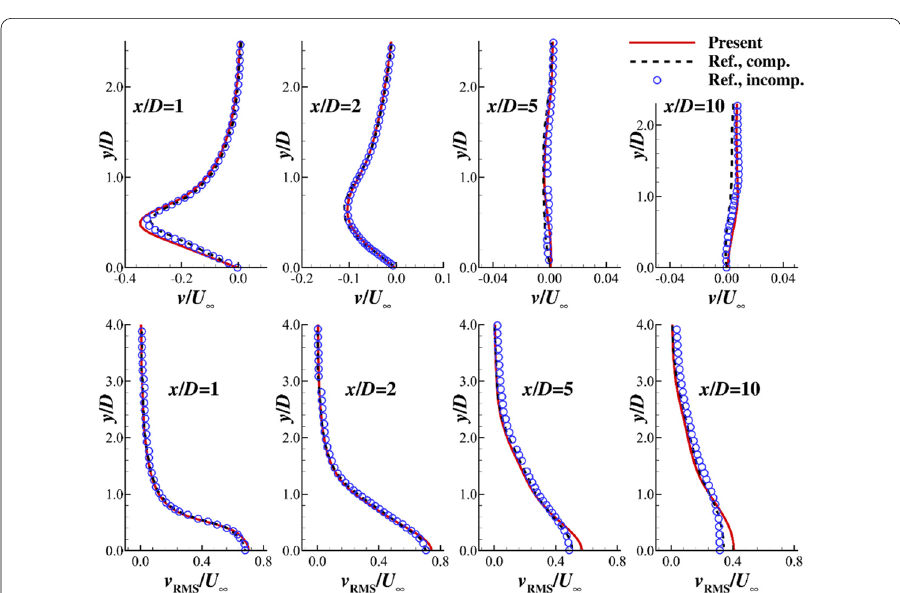
Fig. 7 Averaged streamwise velocity v and root-mean-square of